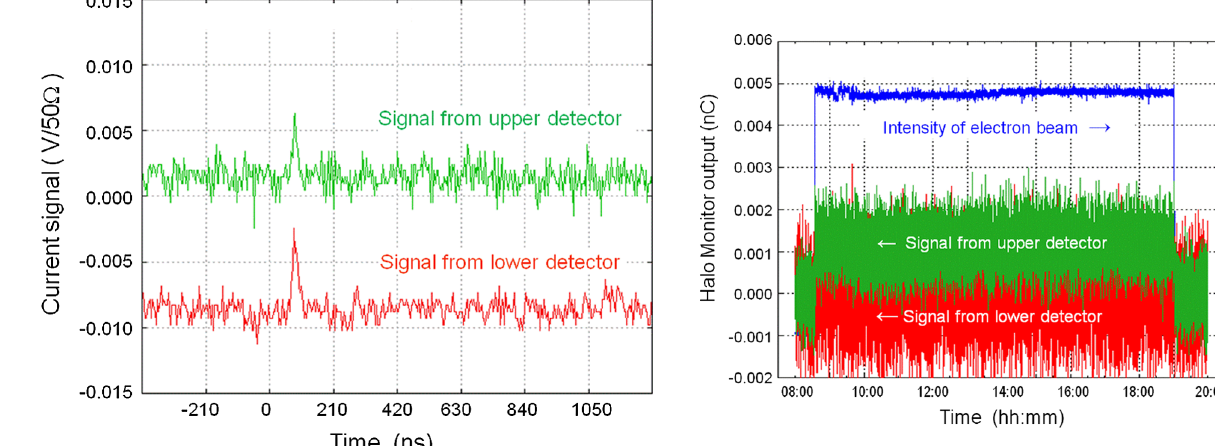
FIG. 21. Result of stability test. The left axis shows the integral output signal of the beam halo monitor (upper: green; lower: red), and the right axis shows the intensity of the electron beam (blue). The gap between the detectors is 4